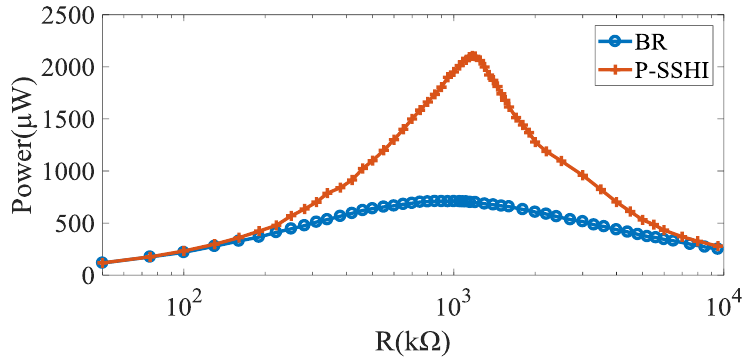
Figure 9. Harvested power versus load under the same displacement amplitude.